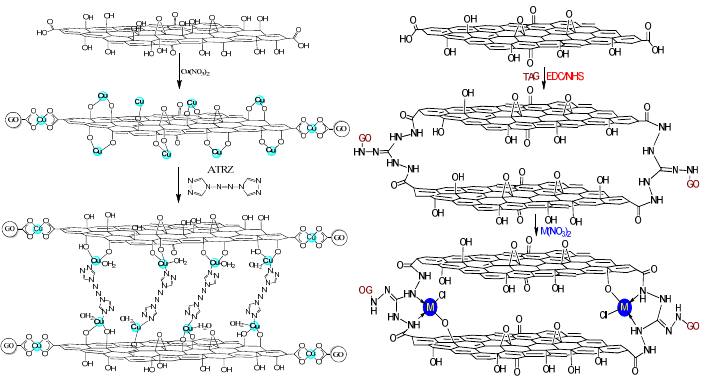
Figure 7. Graphene-Cu (II)-4,4’-azo 1,2,4-triazole and graphene-triaminoguanidine M were pre- pared by